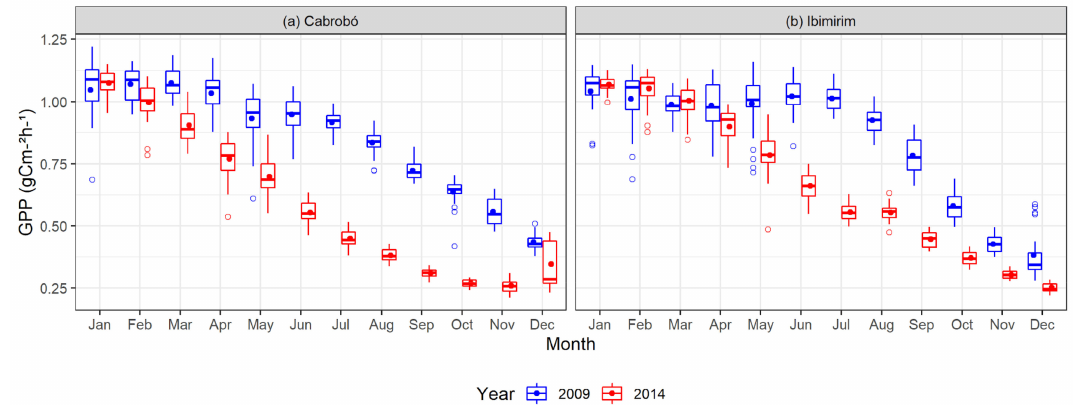
Figure 10. Monthly boxplots of hourly simulated gross primary production (GPP) in the Cabrob ó and Ibimirim sites in 2009 (wet year) and 2014 (dry